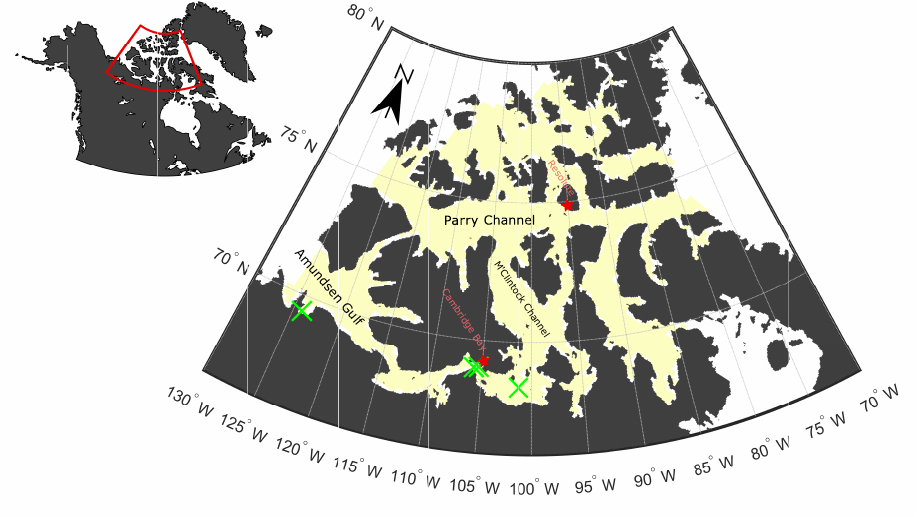
Figure 1. The National Snow and Ice Data Center (NSIDC) region definition of the Canadian Arctic Archipelago (CAA) (light yellow). The locations of the profiler data used for validation are indicated by the green markers. The blue box indicates the approximate location of the Sentinel-1 image used in the discussion of melt onset (MO) for first year and multiyear ice (Section